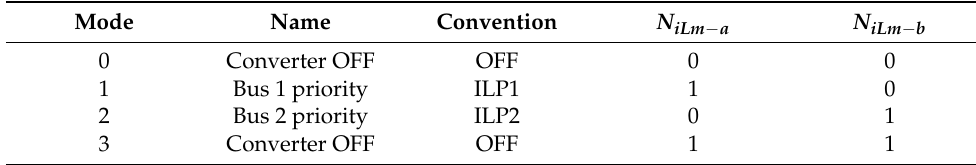
Table 4. Operation modes of the ILCs.